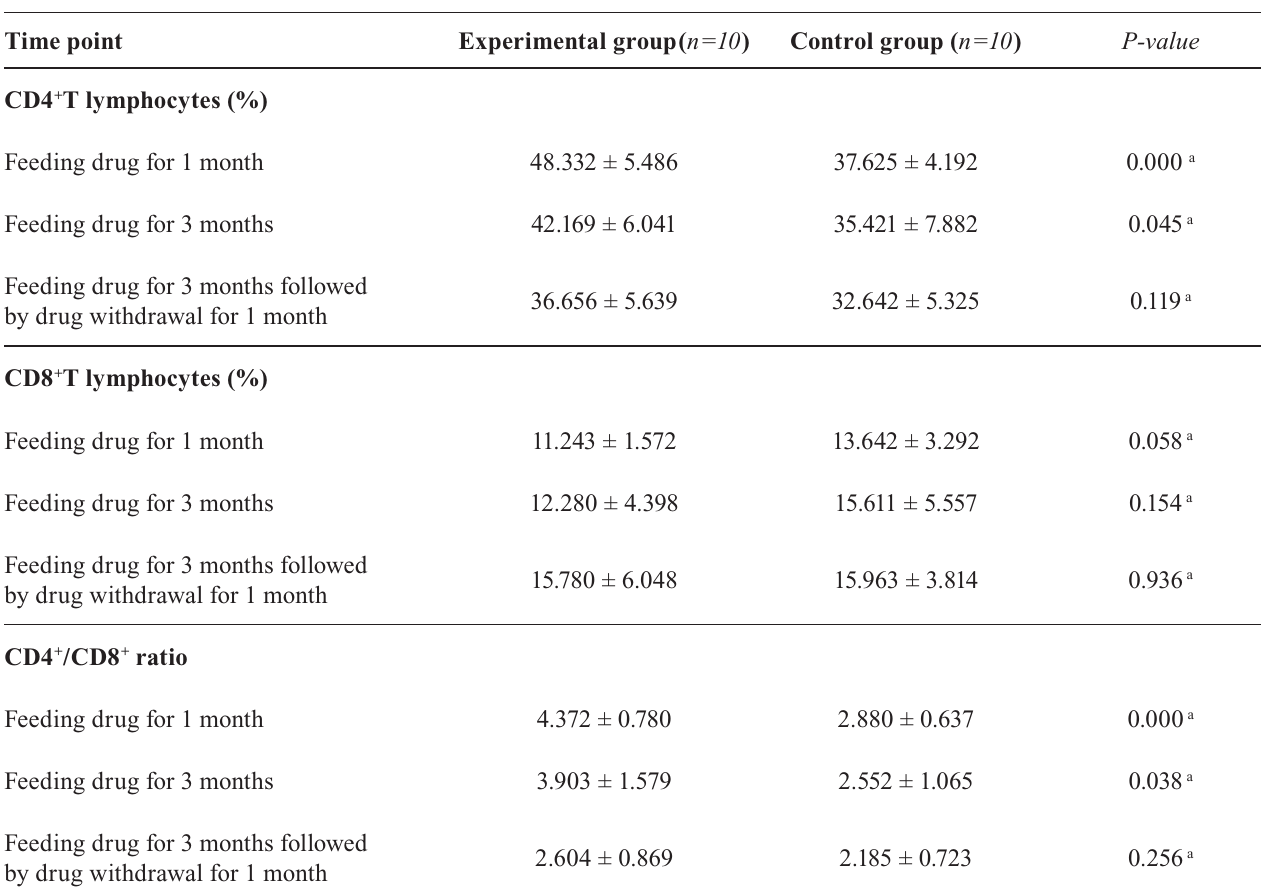
TABLE I - Comparison of CD4 + , CD8 + T lymphocytes and CD4 + /CD8 + ratio in the experimental and control groups at the three time